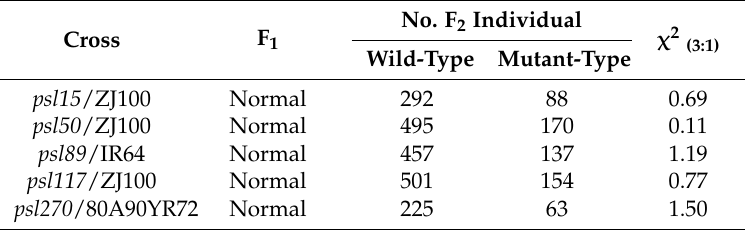
Table 3. Allelism test of premature senescence leaf mutants.